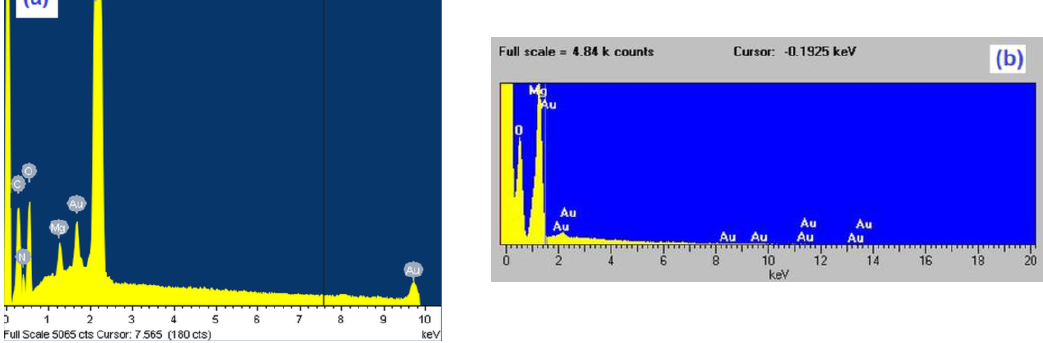
Figure 2. Scanning electron microscopy (SEM) micrographs of Au substrate after Mg electrodeposition by using potentiostatic techniques from: ( a ) magnesium/ammonium nitrate eutectic mixture melt at 400 K and ( b ) nonaqueous magnesium/ammonium nitrate eutectic mixture melt at 460 K.